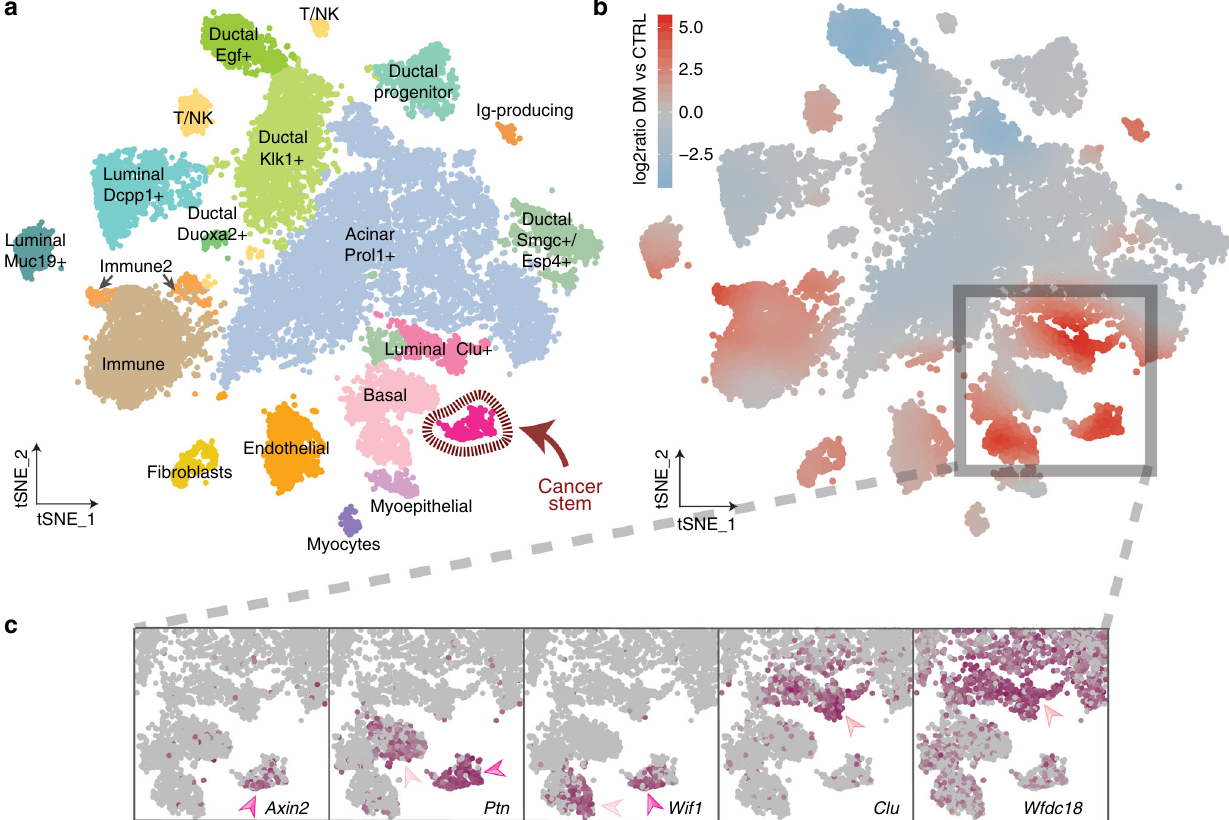
Fig. 2 Single-cell sequencing identi fi es a distinct cancer stem cell-like and other tumor-speci fi c cell populations. a Clustering of combined single-cell sequencing data from control and double-mutant ( β -cat GOF ; Bmpr1a LOF ) tumor-bearing salivary glands shown in the tSNE. Tumor-speci fi c epithelial cell clusters are shown in the lower right part of the tSNE in shades of pink: cancer stem, basal, luminal Clu + cells. b Same tSNE plot showing the relative local densities of control and double-mutant cells. Color gradients reveal clusters that are predominantly represented by double-mutant (red), control (blue) or both double-mutant and control cells (gray). c Expression of Axin2, Ptn, Wif1, Clu , and Wfdc18 in the tumor-speci fi c epithelial subset of the tSNE representation as indicated by a color scale ranging from gray (no expression) to maroon (high